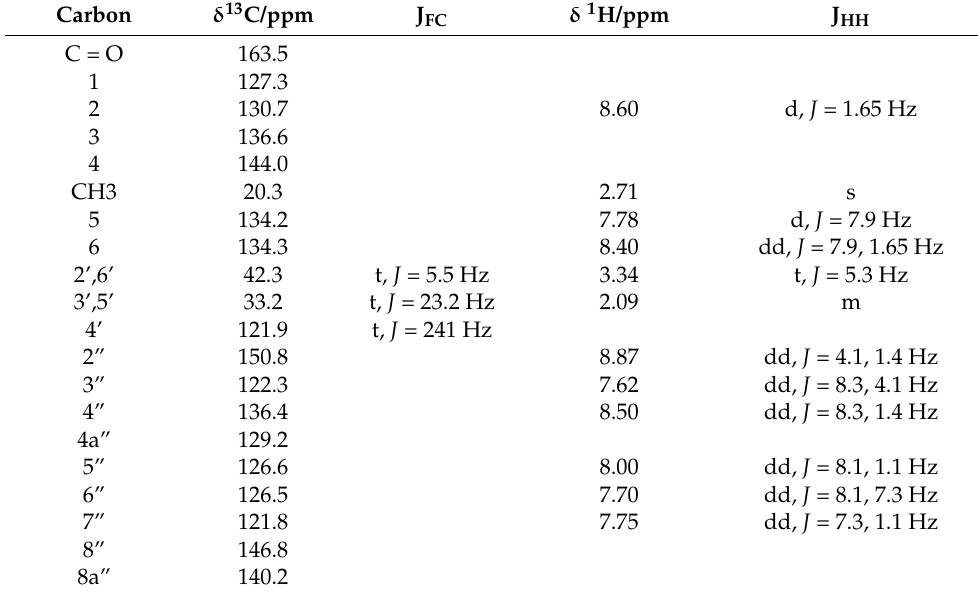
Figure 2. 1 H NMR spectrum of sample 9 in DMSO-d 6 with expansions of ( a ) the aromatic region ( b ) and ( c ) the aliphatic region. The signals annotated with an asterisk ( * ) are from other unidentified species extracted from the matrix. Table 1. 1 H and 13 C NMR peak assignments and coupling constants for